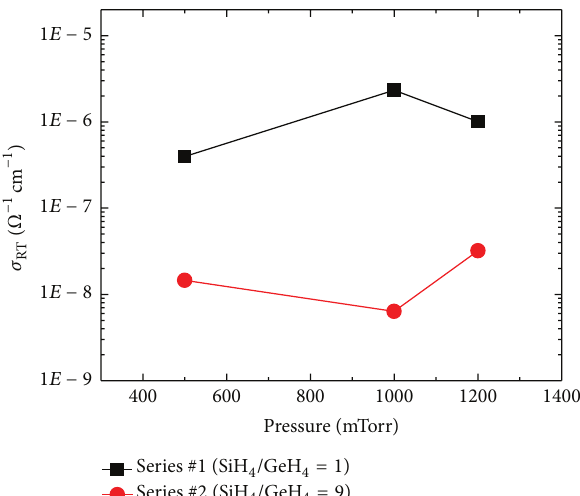
Figure 8: Room temperature conductivity ( 𝜎 RT ) in two series of pm-Si 𝑥 Ge 𝑦 :H deposited films. Series #1: SiH 4 /GeH 4 = 1 and Series #2: SiH 4 /GeH 4 = 9.